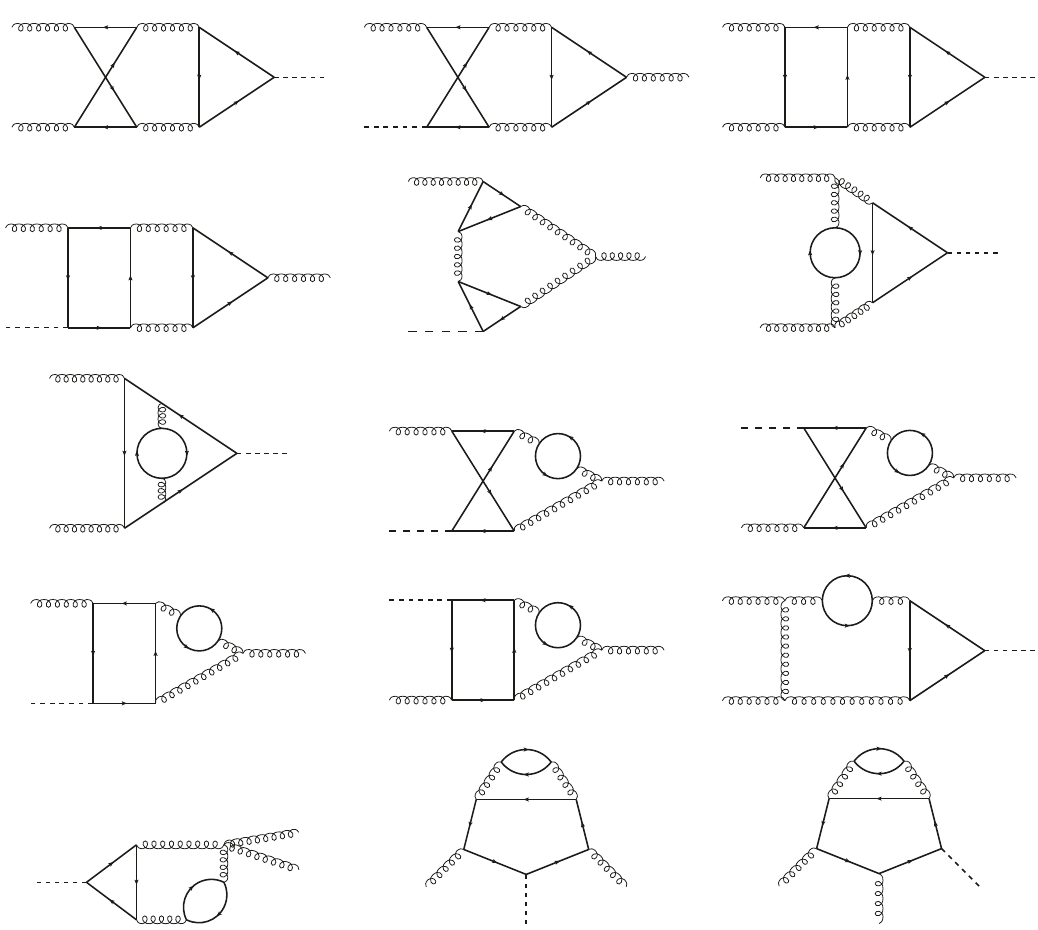
Figure 1 . Complete set of Feynman diagrams with two fermion loops contributing to the Higgs- gluon form factor at three-loop order. The fermion loop connected to the Higgs-boson line cor- responds to a massive quark. The quark of the second fermion loop may be either massive or